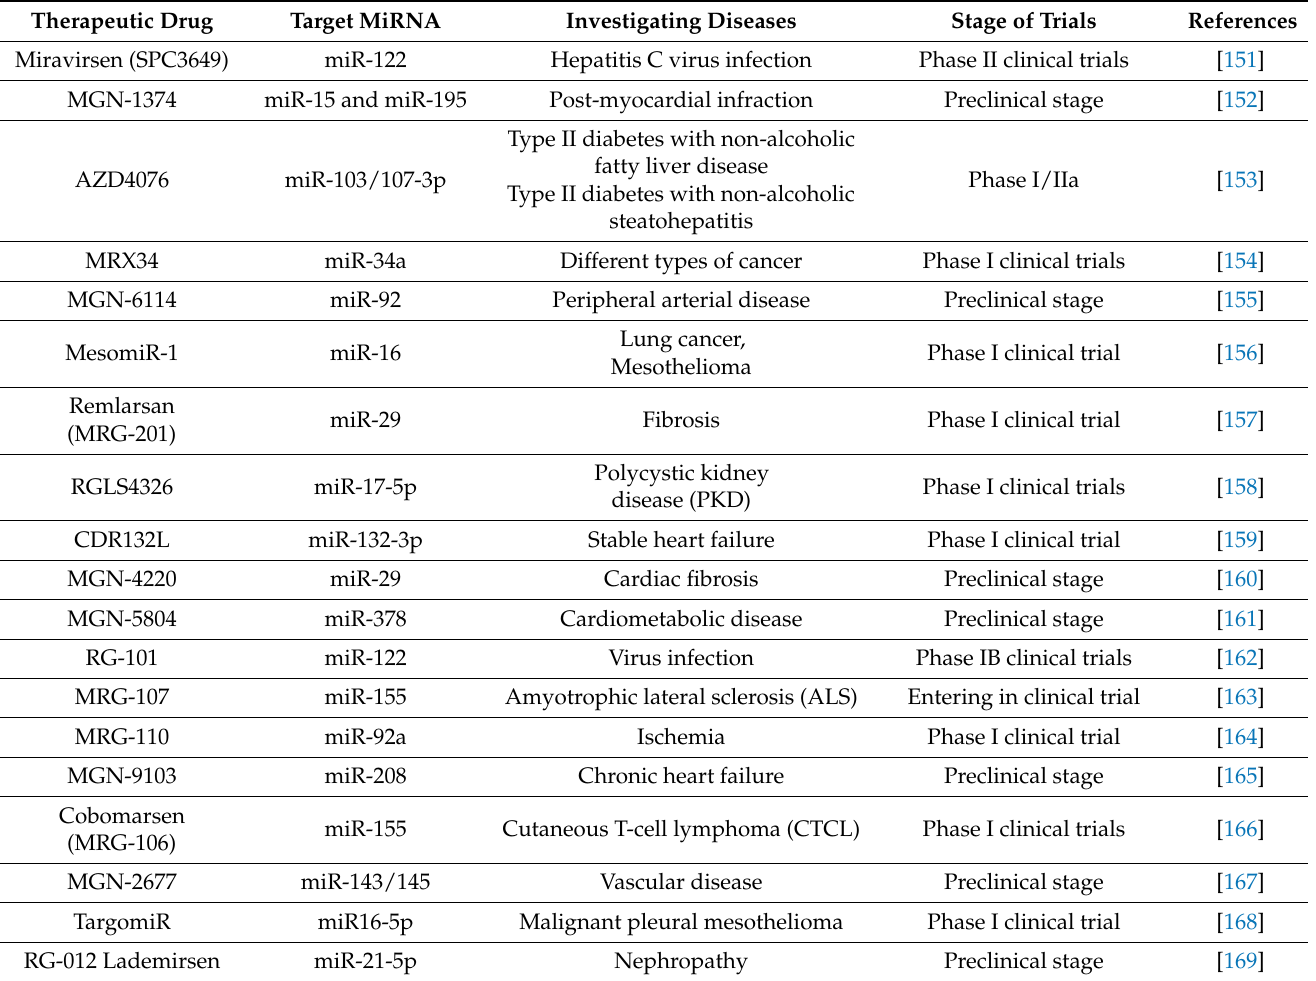
Table 2. miRNA with Therapeutic Potential in the Development